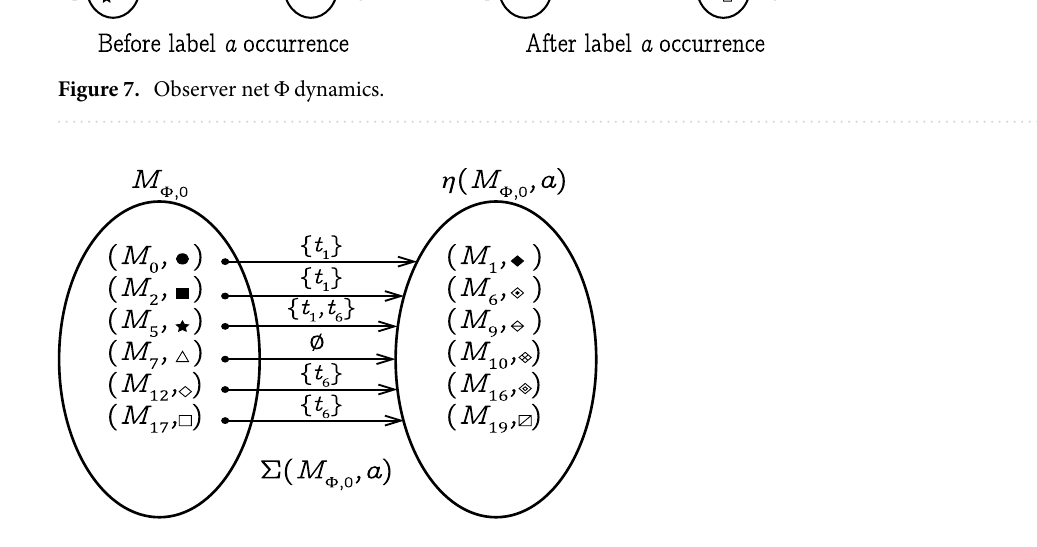
Figure 8. The set of markings reachable from M (cid:31) ,0 by firing transitions with label a